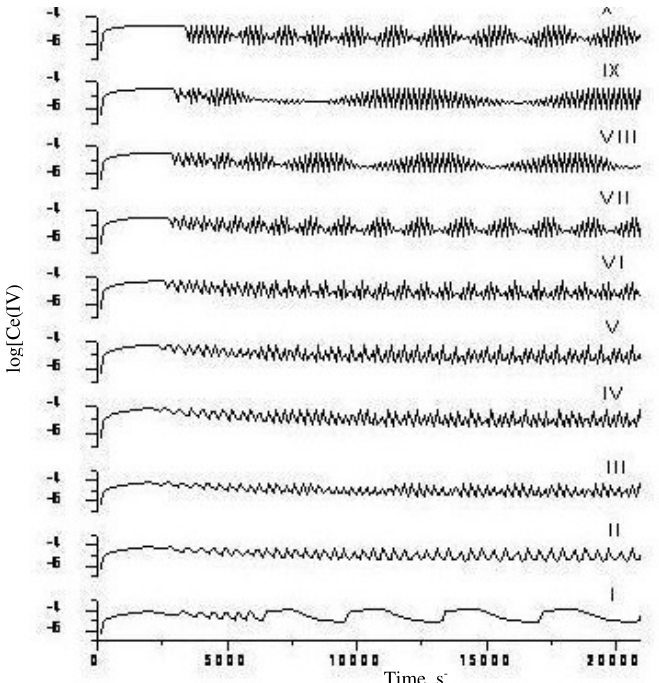
Figure 2 . Dependence of oscillatory characteristics on malonic acid concentrations. System: [H 2 O]=55 M, [BrO 3 - ]=0.1 M and [H + ]=0.26 M and [MA] 0 : (I)=0.001 M, (II)=0.002 M, (III)= 0.004 M, (IV)=0.008 M, (V)=0.02 M, (VI)=0.04 M, (VII)=0.06 M, (VIII)=0.08 M, (IX)=0.1 M, (X)= 0.2